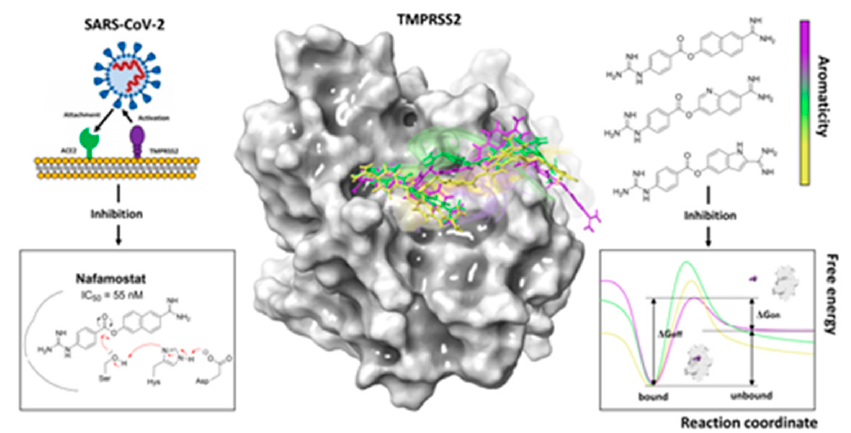
Figure 23. Scheme of TMPRSS2 targeting by nafamostat-based derivatives for potential SARS-CoV-2 inhibition.